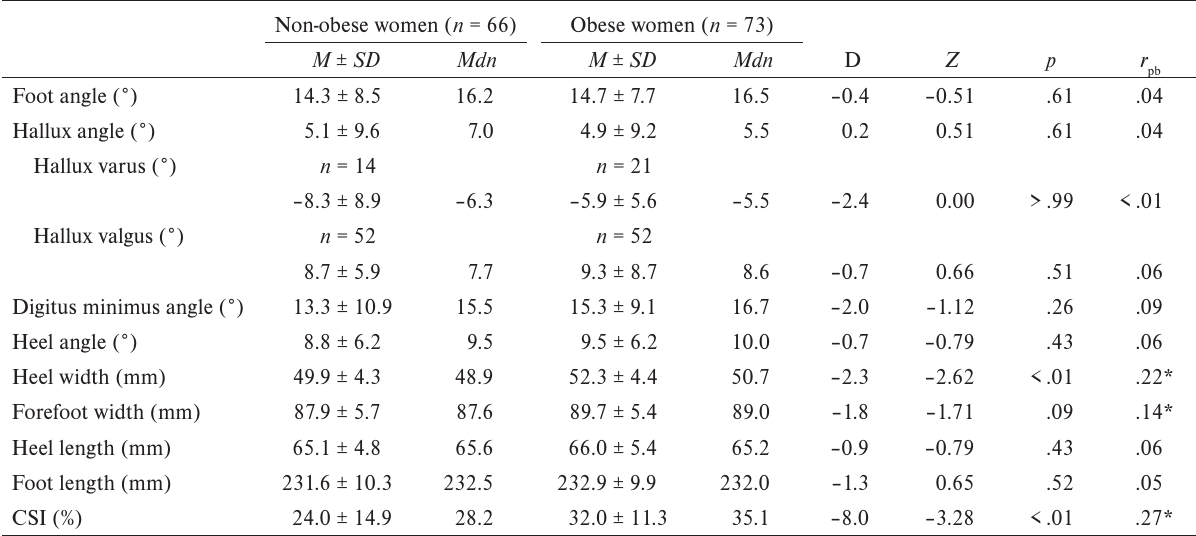
Comparison of right foot parameters between non-obese and obese